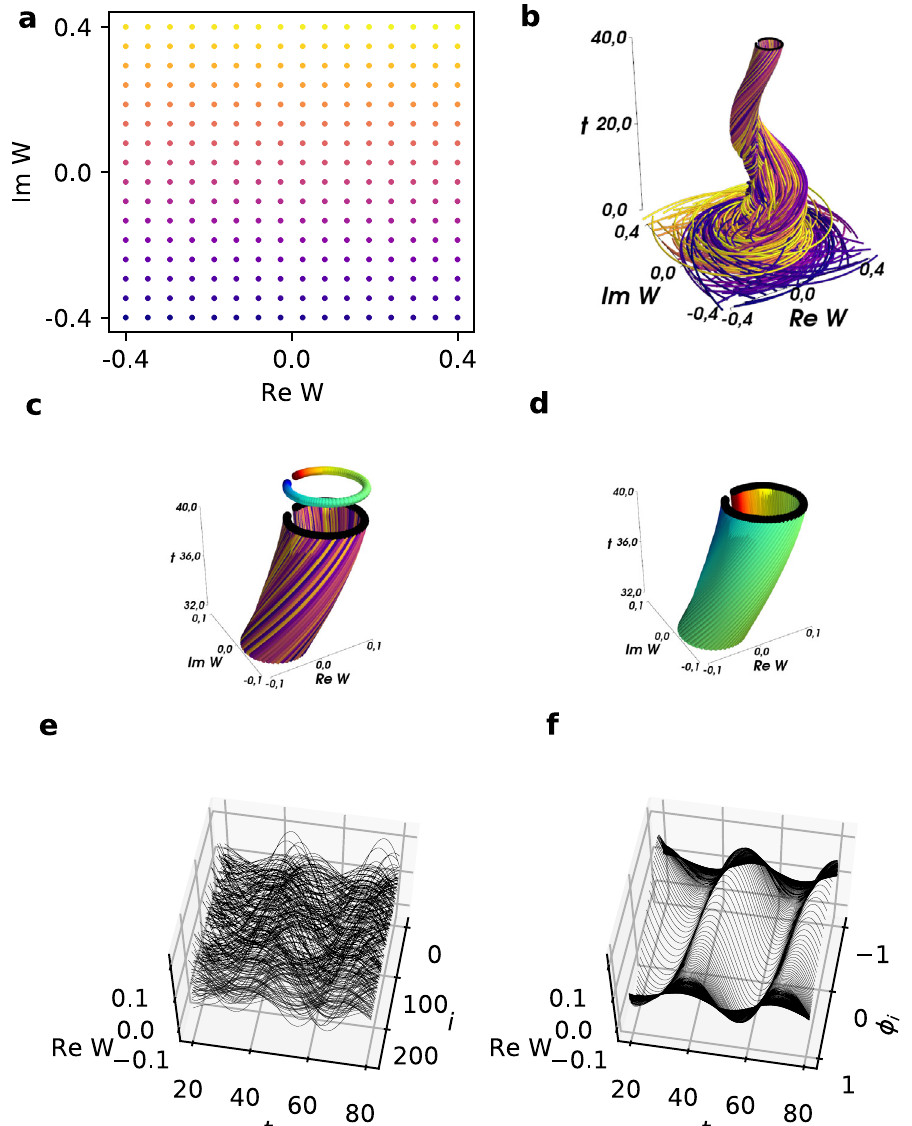
Fig. 1 Illustration of the emergent PDE approach for coupled oscillator systems. a Initial condition of the Stuart-Landau ensemble, Eq. (1), colored with ascending imaginary part of W k . b Trajectories obtained from integrating the initial conditions of ( a ) with the same color coding as in ( a ). The last snapshot is marked by black dots. c Zoom in to the upper part of (b), with the last snapshot marked by black dots. Above it, the last snapshot is color coded based on the ordering of the oscillators along the curve at that moment. d Zoom in on the top part of ( b ), but now with the new color coding. e Trajectories of the real part of the W k , arranged by their initial values Im W . f Trajectories of the real part of the W k , arranged by the new color coding ϕ i as in ( d ). (Finding ϕ i is discussed in the